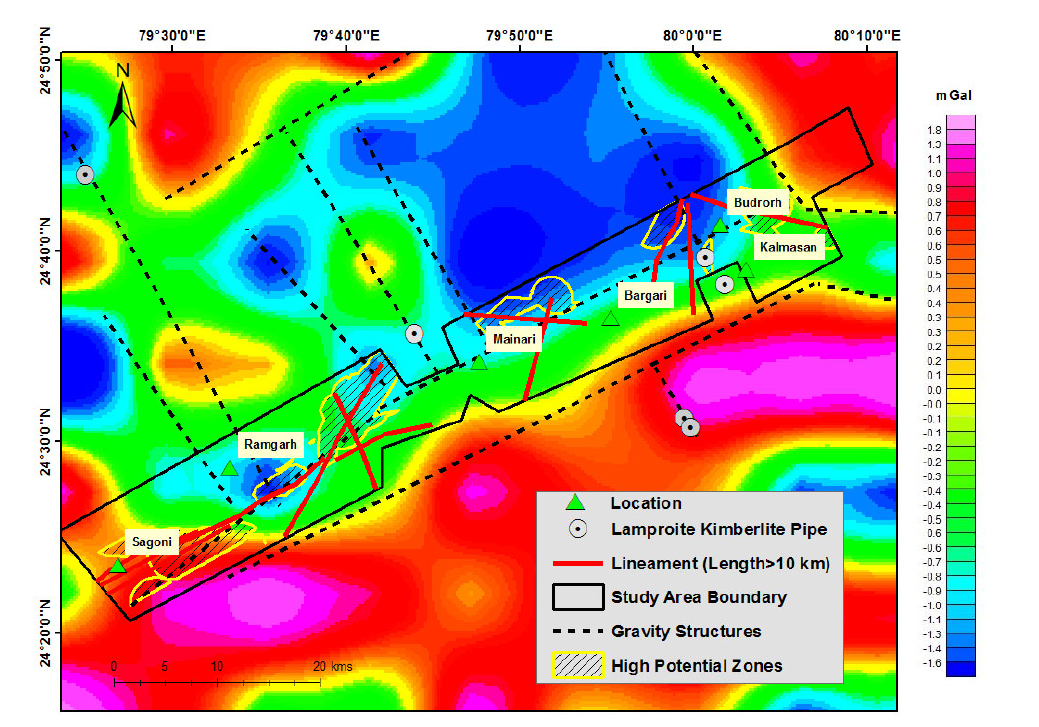
Figure 6. Residual gravity anomaly map showing spatial proximity of prospective zones and lineaments; which have been associated with the discovered pipe. Combined zones of high and moderately potential zones are shown as the out line of prospective zone.